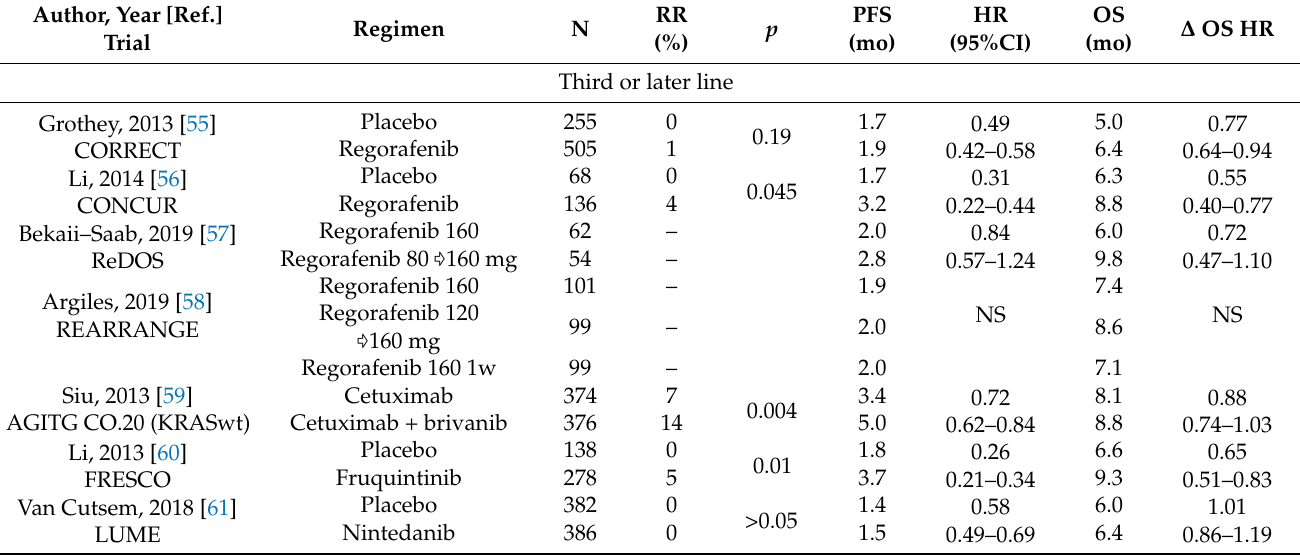
Table 5. Principal randomized trials in which TKIs were used in third or later line therapy in patients with mCRC. Author, Year